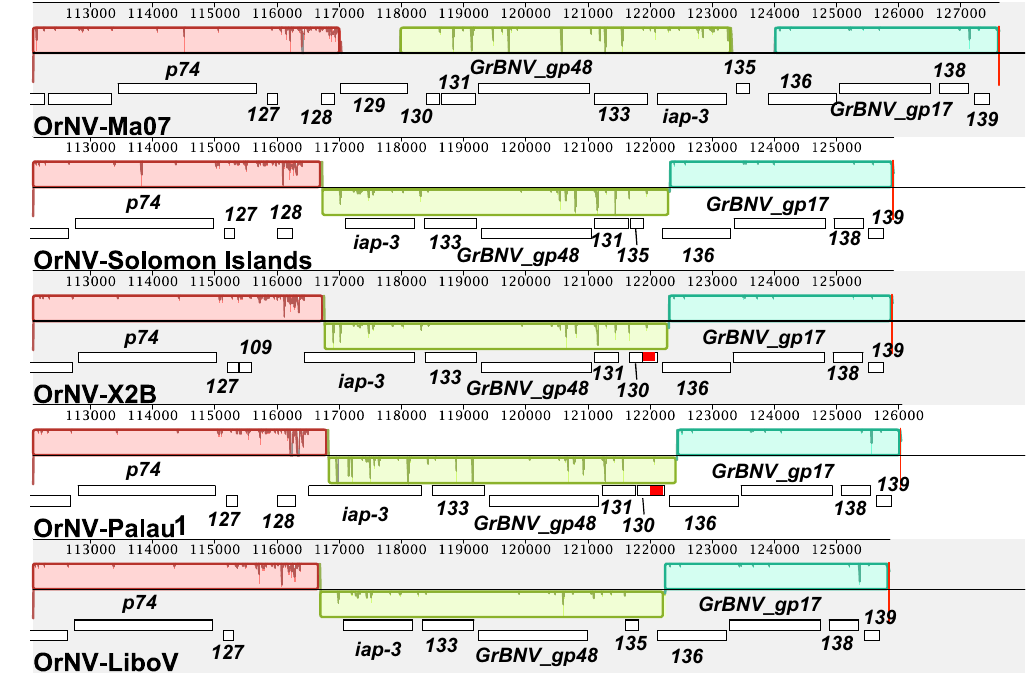
Figure 5. Mauve alignment of a region in OrNV genomes characterized by an inversion. Block outlines of the same color correspond to Locally Collinear Blocks (LCBs) which represent conserved segments of sequence among the isolates. The light green LCB represents the region in Ma07 which is inverted in the other isolates, which is indicated by this LCB occurring below the central tracking line in the Solomon Islands, X2B, Palau1, and LiboV sequences. The regions outside the LCBs lack significant sequence conservation with the alignment consensus and indicate sequences in Ma07 that are missing in the other isolates. Conserved ORFs are indicated by their specific names or by their numbering in the Ma07 genome. The red ORF was identified in the X2B and Palau1 genome sequences but either is not present (Ma07, LiboV) or not annotated (Solomon Islands) in the other